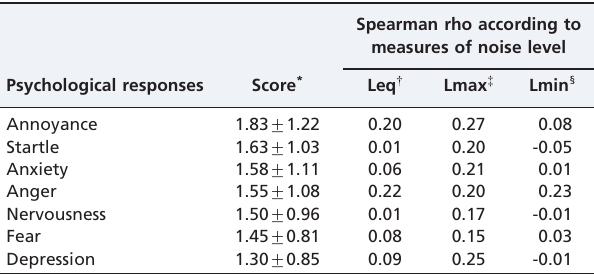
Table 2 - Scores of psychological responses and their correlations with noise level, indicated by Spearman rho coefficients (n=